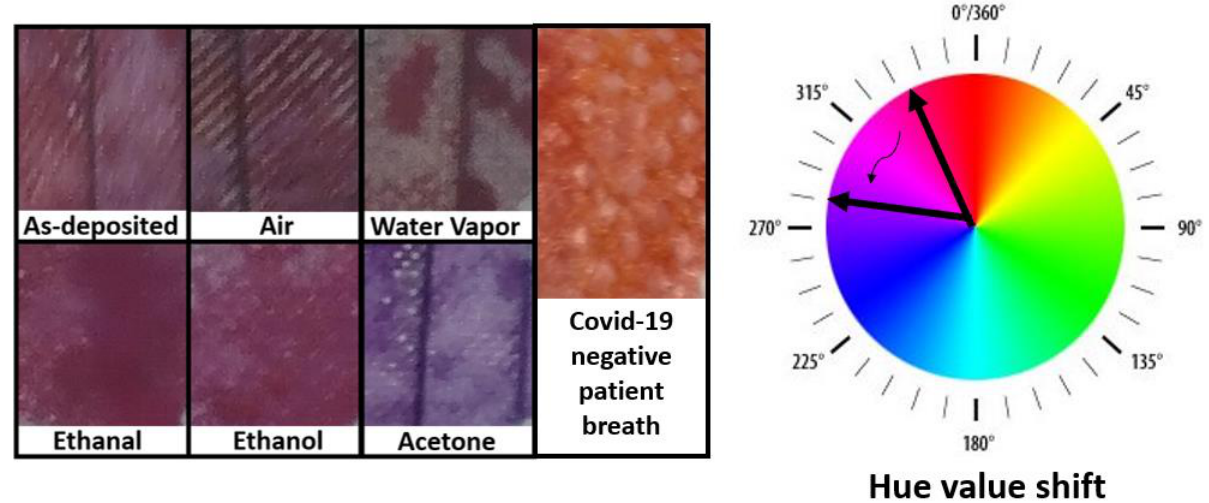
Figure 1. Images of facemask fabrics covered with ethanal-sensitive colorimetric solutions. The masks were exposed to several gases for 8 h. A clear change in color is exclusively observed upon exposition to ethanal.